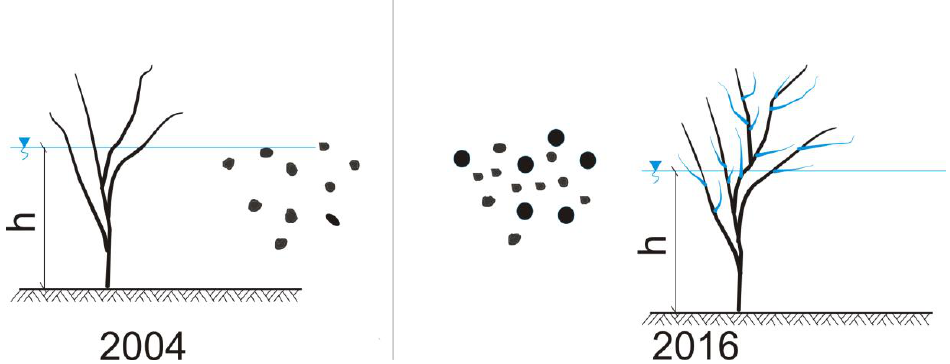
Figure 4. Simulation diagram of the vegetation grown uncontrollably at the beginning (2004) and the end (2016) of observations.